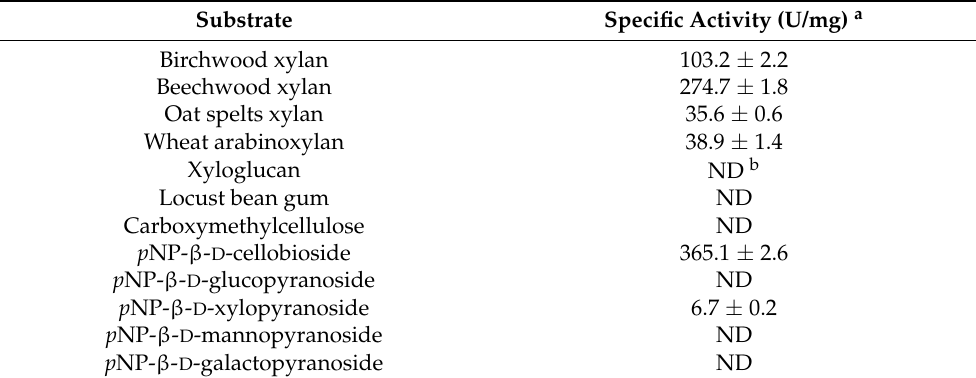
Table 2. Degradation activity of rXylR for different β -1,4- D -xylans and p NP-sugar